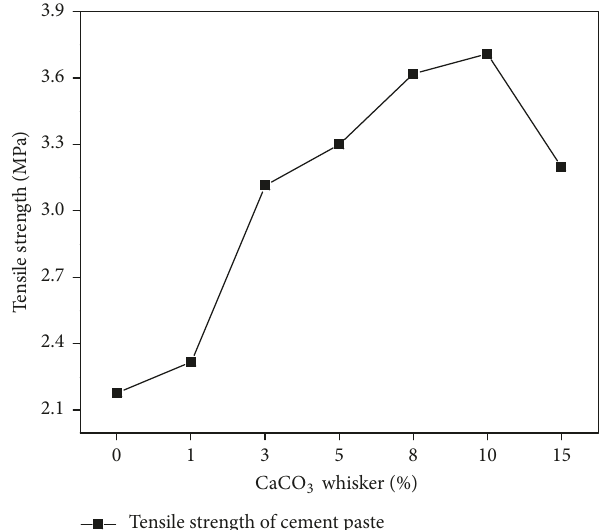
Figure 3: Tensile strength of CaCO 3 whisker.